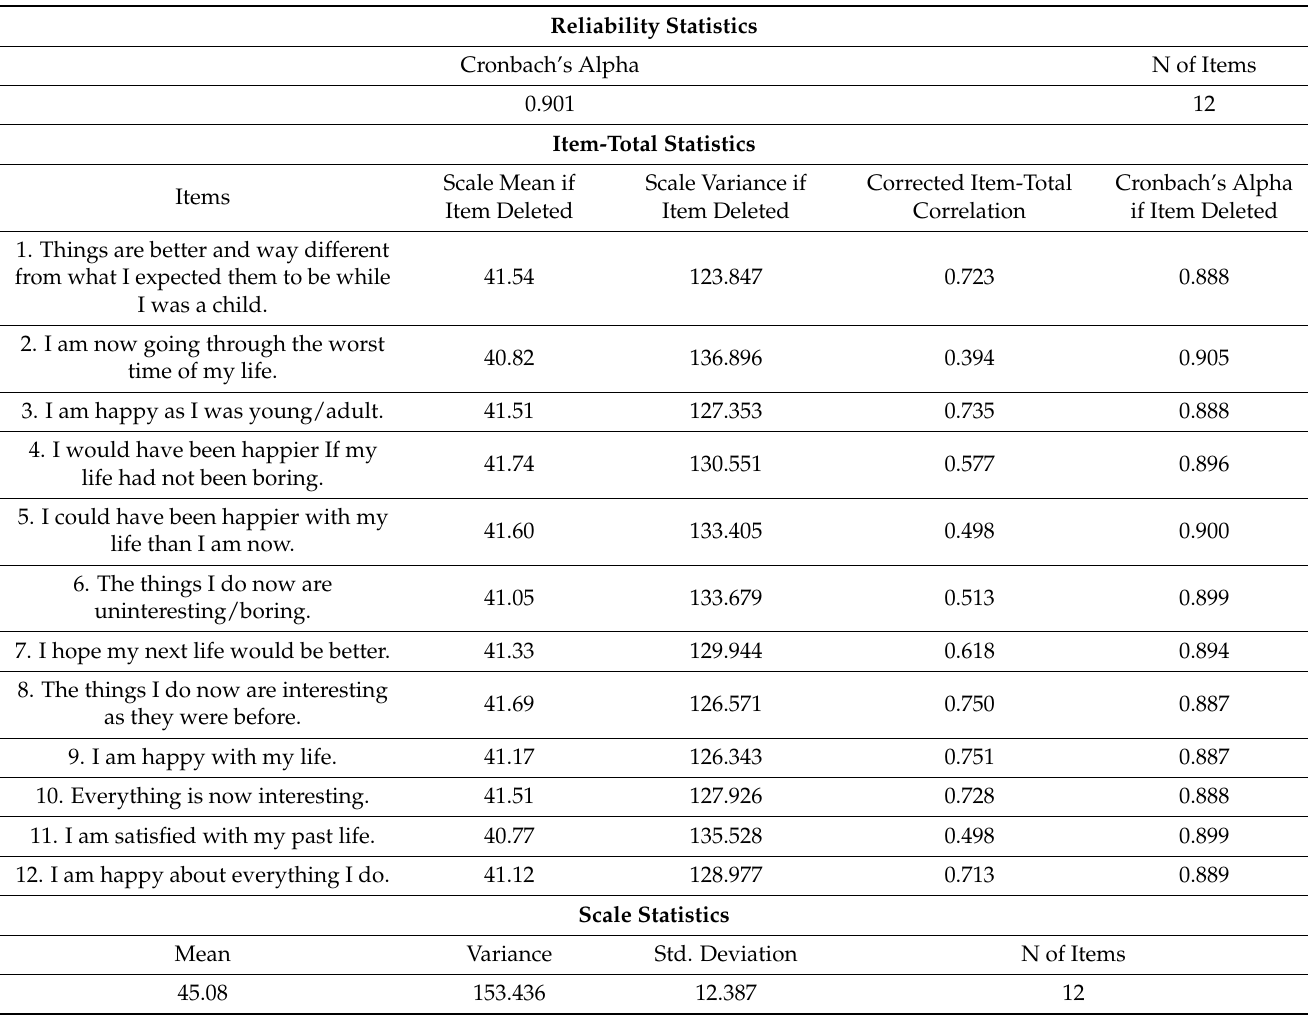
Table 5. Internal consistency (internal validity) of the